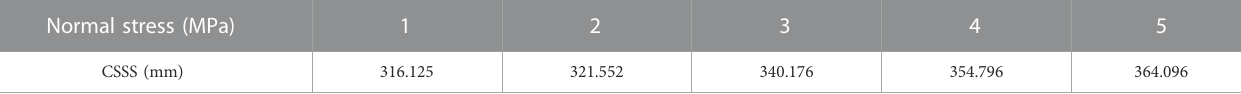
TABLE 9 Relationships between CSSS and normal stress. Normal stress (MPa)